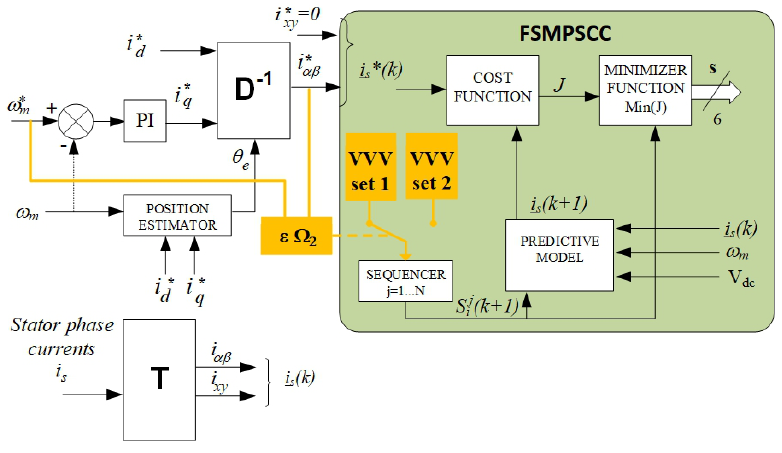
Figure 9. Diagram of the proposed FSMPSCC with two VVV